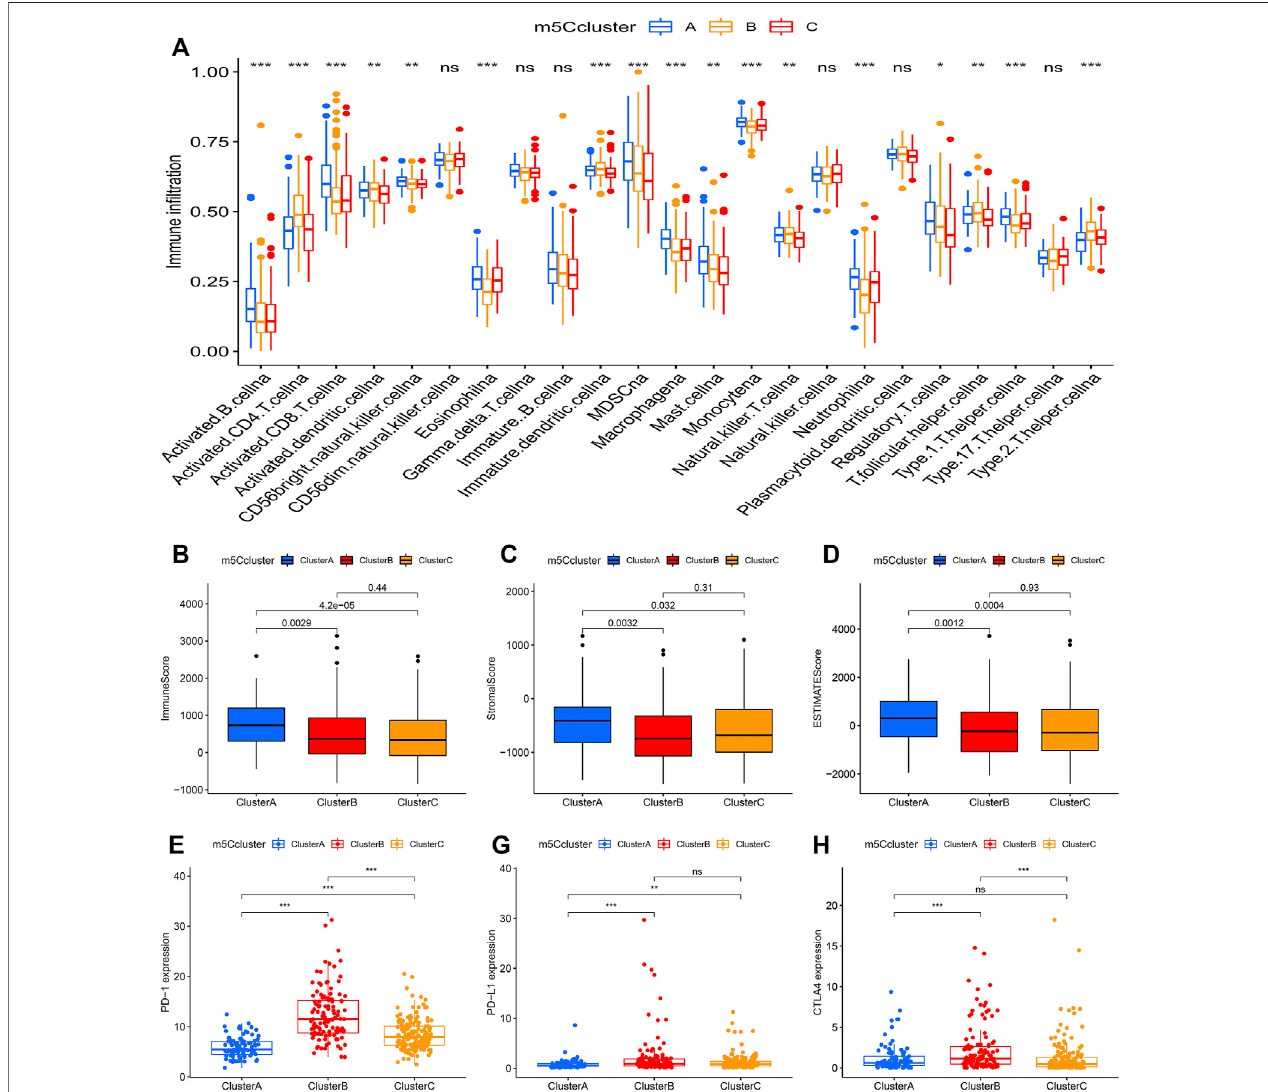
FIGURE 4 | Tumor immune landscape in distinct m5Cclusters. (A) ssGSEA of patients in distinct m5Cclusters, the asterisks represent the statistical p value between the three m5Cclusters (* p < 0.05; ** p < 0.01; *** p < 0.001); (B) Immune score of patients in distinct m5Cclusters; (C) Stromal score of patients in distinct m5Cclusters; (D) ESTIMATE score of patients in distinct m5Cclusters; (E) PD-1 expression in distinct m5Cclusters (* p < 0.05; ** p < 0.01; *** p < 0.001); (F) PD-L1 expression in distinct m5Cclusters (* p < 0.05; ** p < 0.01; *** p < 0.001); (G) CTLA-4 expression in distinct m5Cclusters (* p < 0.05; ** p < 0.01; *** p < 0.001).